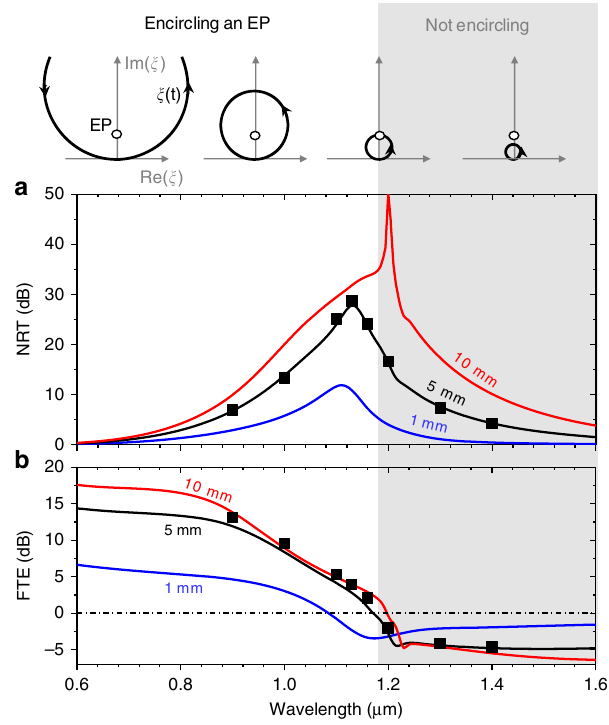
Figure 6 | Broadband performance characteristics. ( a ) Spectral profiles of the nonreciprocal transmission ratio (NTR) for several device length values of L ¼ 1mm (blue), 5mm (black) and 10mm (red). ( b ) Spectral profiles of the forward transmission efficiency (FTE) for L ¼ 1, 5 and 10mm. The curves in both panels are obtained by solving the nonlinear coupled-mode model of equations (1–3), whereas the square symbols for L ¼ 5mm are calculated by the finite-element method. We assume I 0 / I S ¼ 1 in this analysis. The top diagrams above ( a ) schematically show a wavelength- dependent x ( t ) trajectory with respect to the EP. Table 1 | Major performance parameters for model devices.